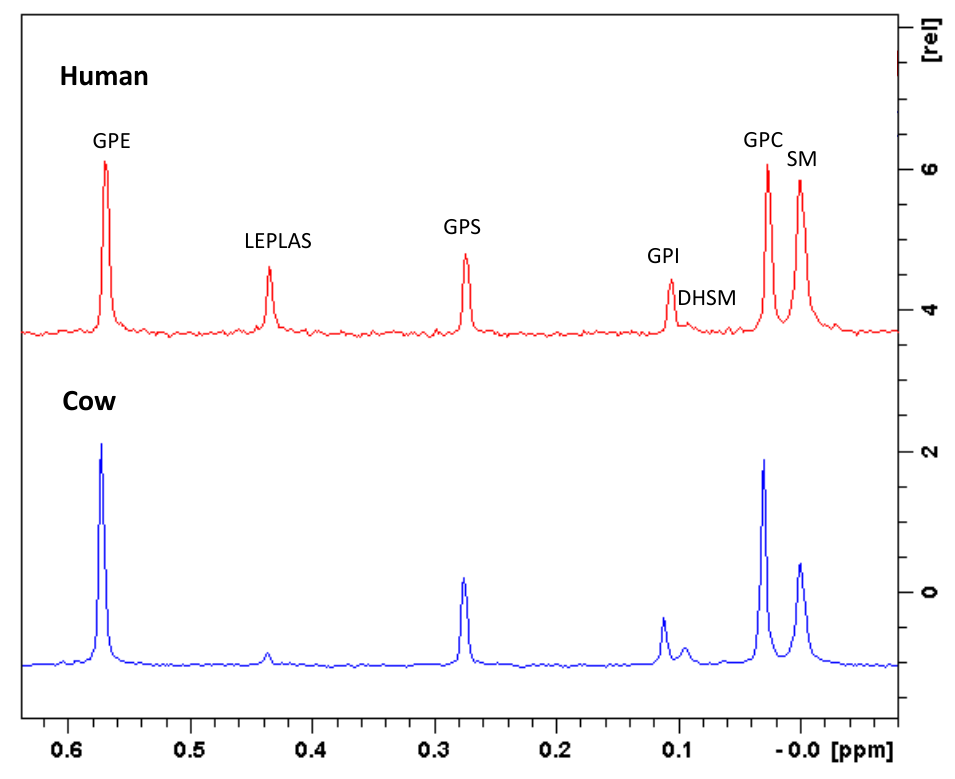
Figure 1. 31 P NMR traces of deacylated Human (red) and Cow (blue) phospholipids. Chemical shifts are shown relative to SM. Abbreviations: GPE—glycerophosphoethanolamine, LEPLAS—lyso − ethanolamine plasmalogen, GPS—glycerophosphoserine, GPI—glycerophosphoinositol, DHSM—dihydrosphingomyelin, GPC—glycerophosphocholine,